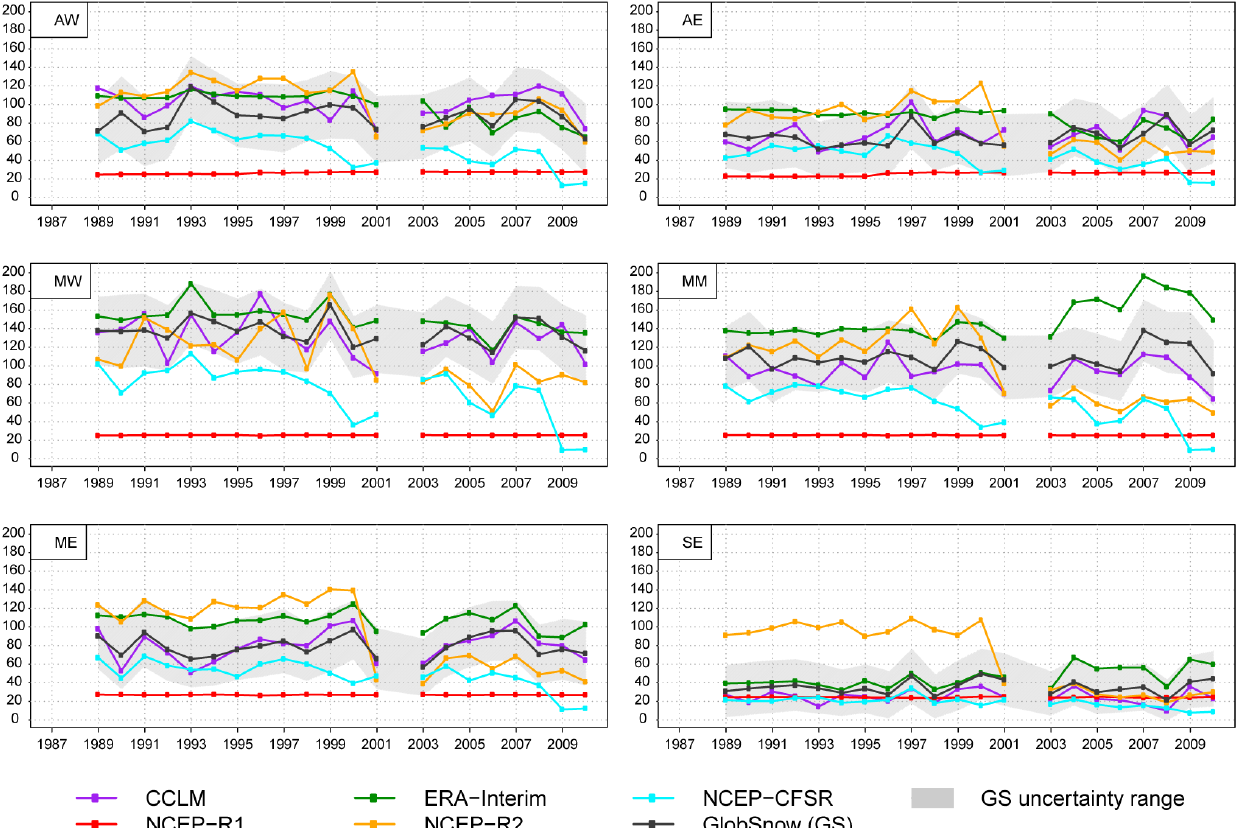
Fig. 5. Time series mean January SWE [mm] (1987–2010) for all considered datasets for different subregions. The gray shaded area represents the uncertainty range of GlobSnow. Data gaps occur where GlobSnow provides SWE with more than 3 missing days per month. These months are excluded in all